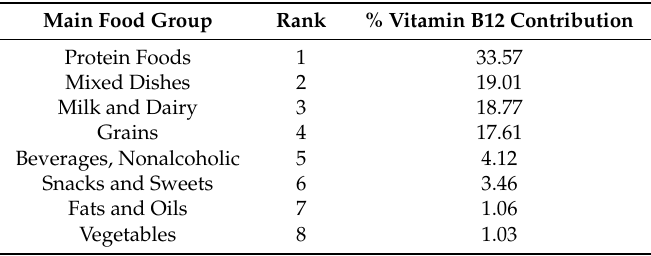
Table 21. Food sources of vitamin B12 contribution in the total U.S. diet, adults ≥ 51 years old ( n = 4522; gender combined; daily intake data; NHANES 2011–2014; main food groups contributing <1.0% not reported; data are Day 1